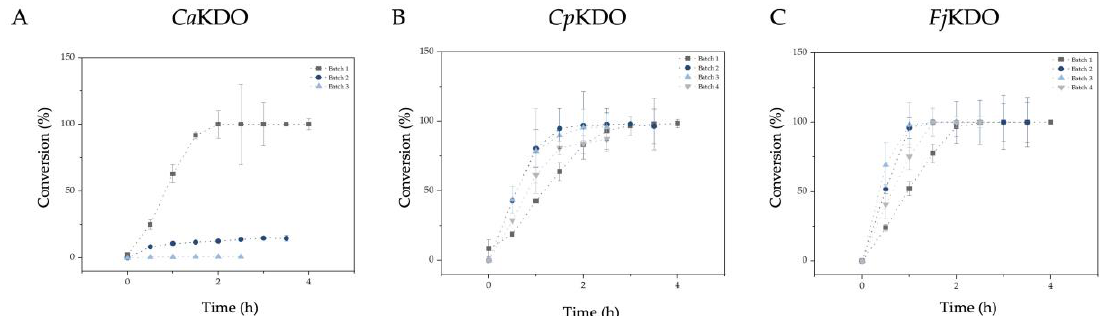
Figure 5. Repetitive batch studies with three HaloTag ® -immobilized KDO ( A ) Ca KDO ( B ) Cp KDO ( C ) Fj KDO. Reactions were performed in a 1 mL scale in 200 mM HEPES, pH 7.5, with 5 mg mL −1 immobilized enzyme, 100 mM L-lysine, 150 mM α -KG, 2.5 mM L-ascorbic acid, 0.01 mM DTT, and 1 mM (NH 4 ) 2 Fe(SO 4 ) 2 for 24 h at 25 ◦ C in an overhead shaker. After each batch, the immobilized catalyst was precipitated by centrifugation, washed 4 times with 50 mM HEPES, pH 7.5, and stored over night at 4 ◦ C until the next reaction was started with a freshly prepared reaction mixture. Error bars are the result of two independent